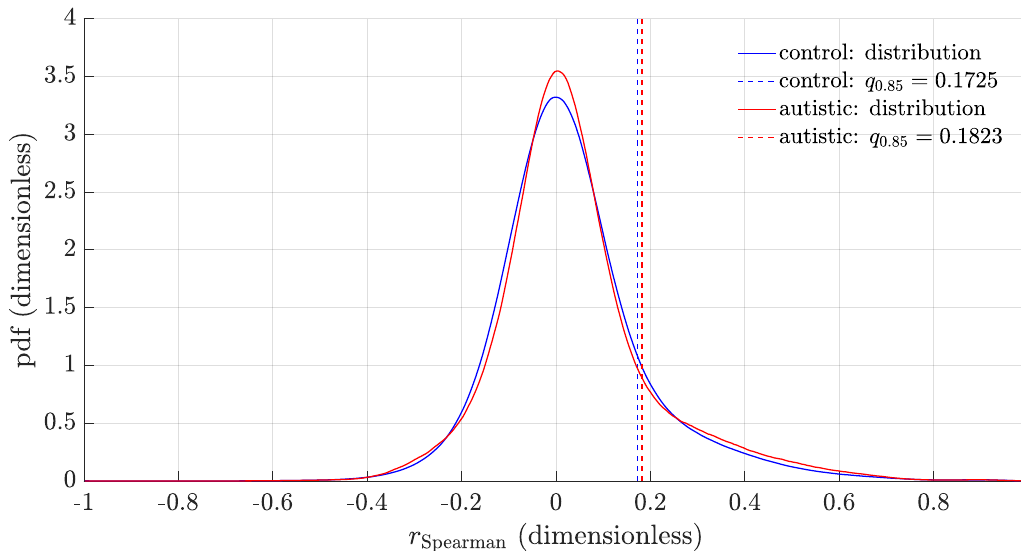
Figure 2. Distribution of the Spearman’s correlation coefficients for the TD and AUT groups. The 85th percentile of each distribution is also shown (average value for TD, a single value for AUT), used as the threshold for network reconstruction.